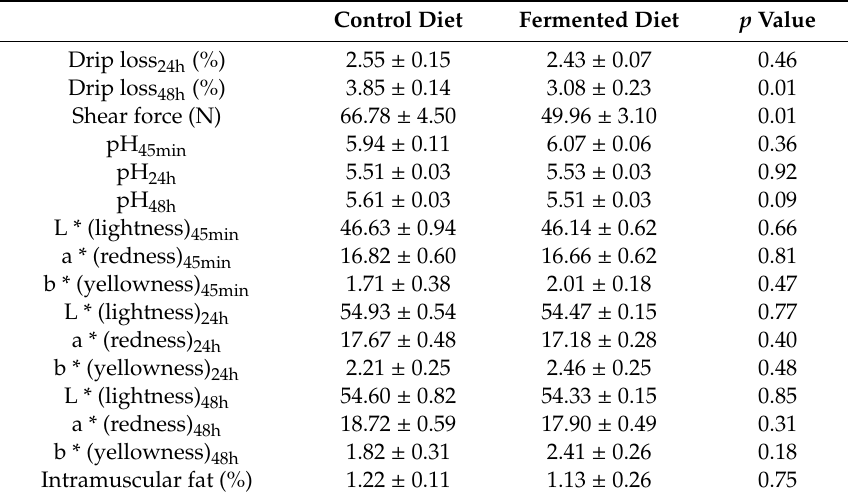
Table 5. Diets e ff ect on the meat quality of longissimus thoracis muscle.